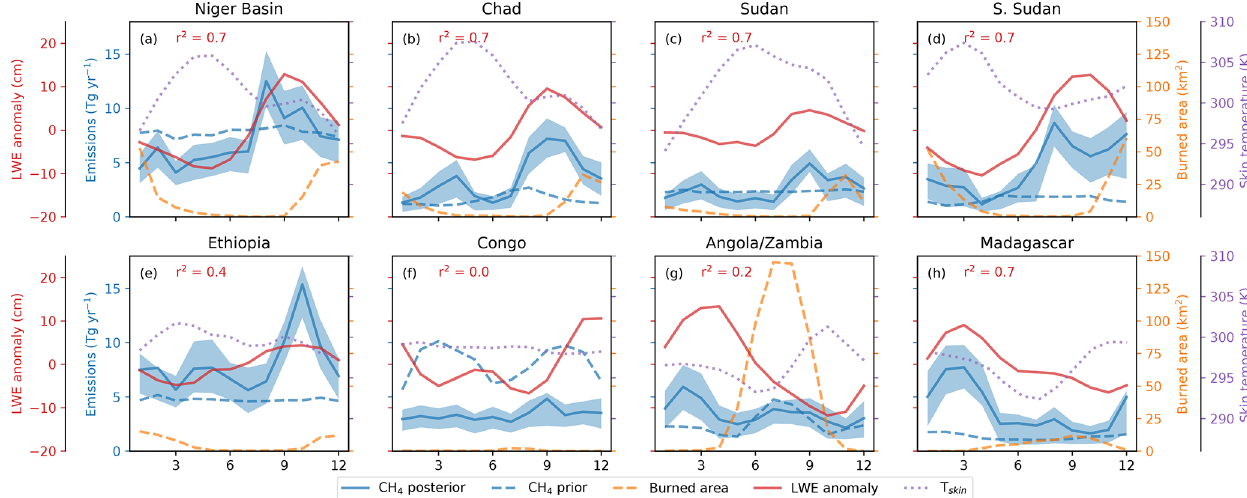
Figure 8. Mean seasonal cycle of a posteriori CH 4 (solid blue) emissions from eight regions across tropical Africa. Shading represents the 95% uncertainty range. Also shown are the a priori emissions (dashed blue), burned area (orange dashes), GRACE liquid water equivalent height anomaly (LWE, red), and surface skin temperature ( T skin ) estimates from MERRA-2 (purple dots). Panels (a) – (e) represent regions in Northern Hemisphere Africa with the CH 4 emissions peak in the latter part of the year, and (g) – (h) represent regions in Southern Hemisphere Africa where the CH 4 emission peak is at the start of the year. (f) Congo straddles the Equator. The r 2 value represents the correlation coefficient between a posteriori emissions and LWE